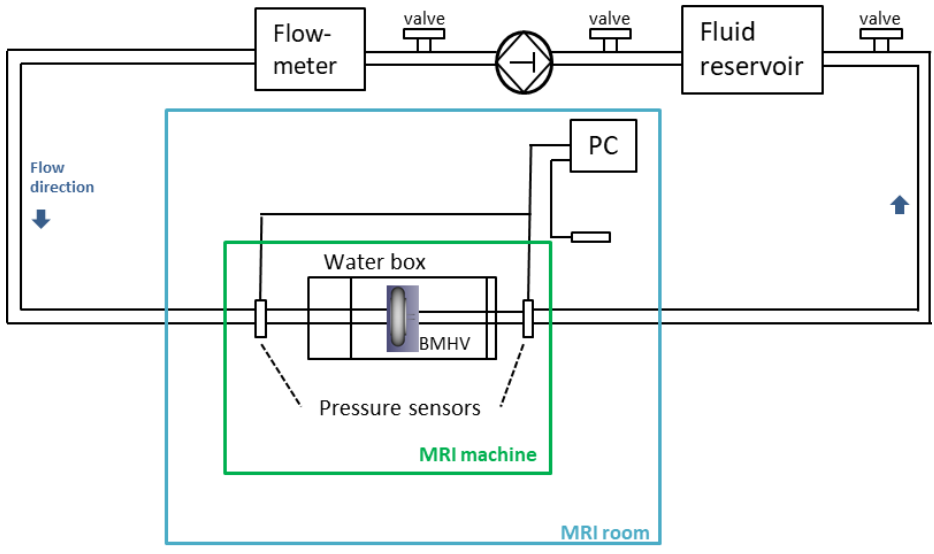
Figure 1. Schematic of the experiment, adapted from [13] with gear pump, pressure measurement, and set up outside of the MRI. PC: Personal computer.